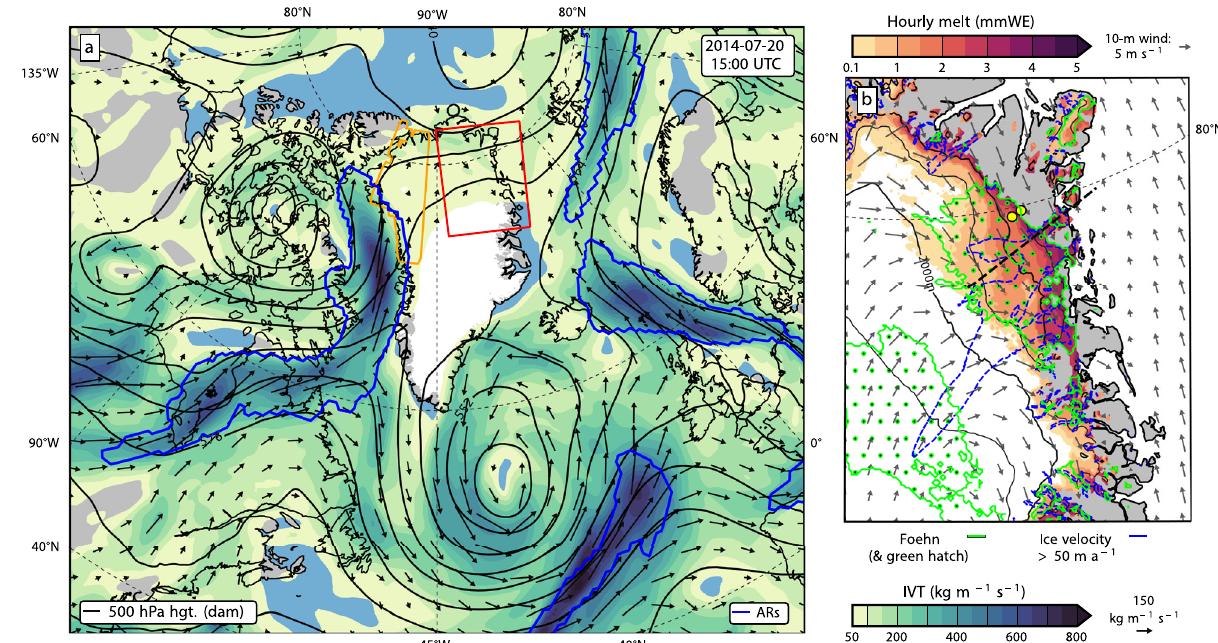
Fig. 1 | 20 July 2014 atmospheric river (AR) and melt event. a Map displaying outline of an AR affecting northwest (NW) Greenland (outlined in blue) from the Modern-Era Retrospective analysis for Research and Applications, Version 2 (MERRA-2) reanalysis at 20 July 2014 15:00 UTC along with integrated water vapor transport(IVT)(colorshadingand vectorarrows)and 500hPageopotentialheight contours (black lines). Also shown are the northeast (NE) Greenland study domain (red outline), and the NW Greenland domain used for analysis of AR impacts in